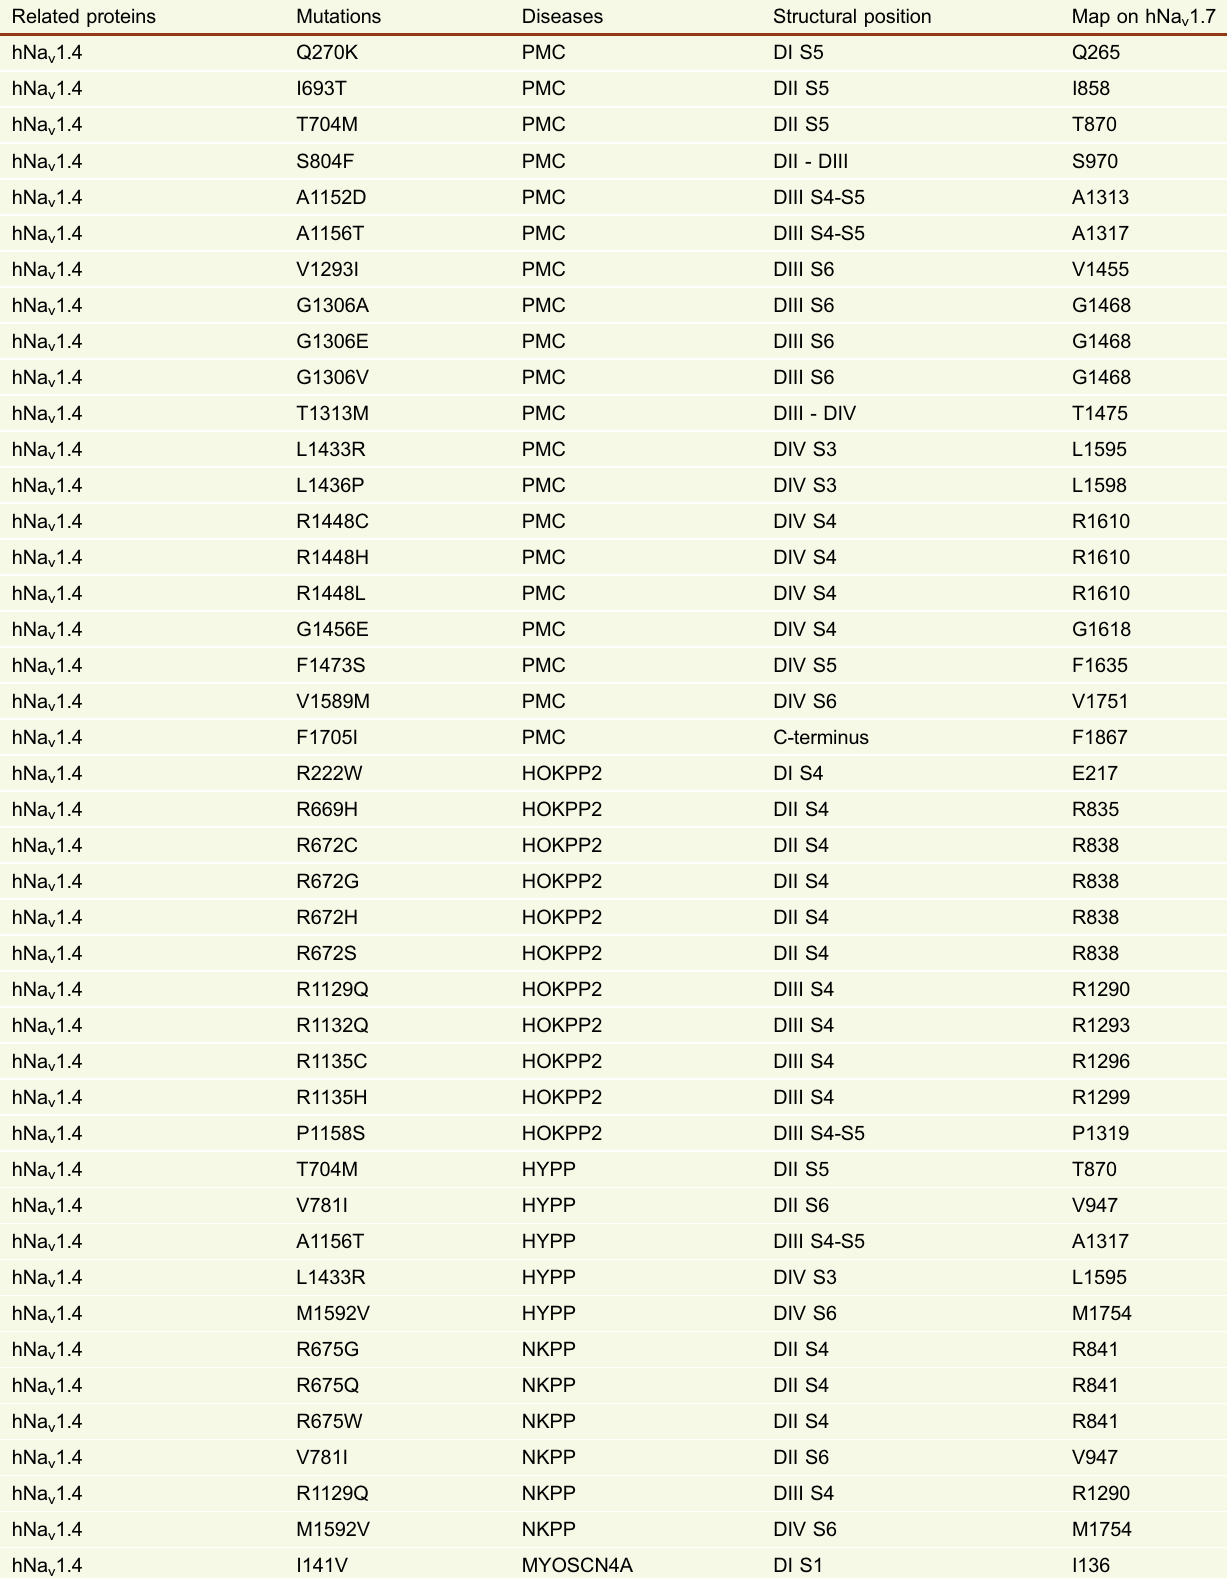
Table 5. Structural mapping of disease-related mutations identi fi ed in human Na v